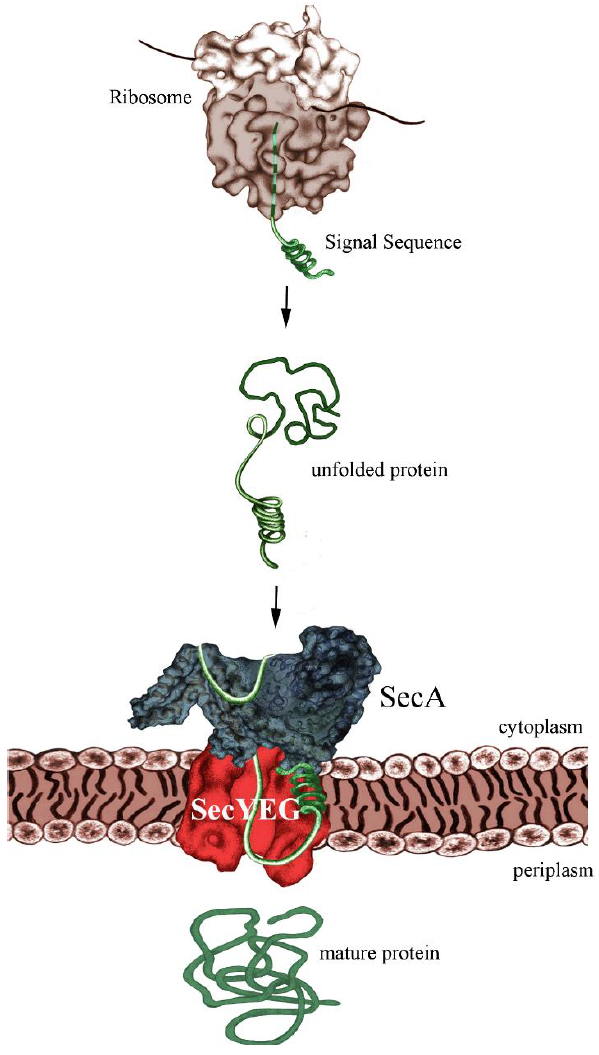
FIGURE 1: SecA-dependent post-translational targeting of secre- tory proteins to the SecYEG-translocon. For simplicity, chaperone interactions are not